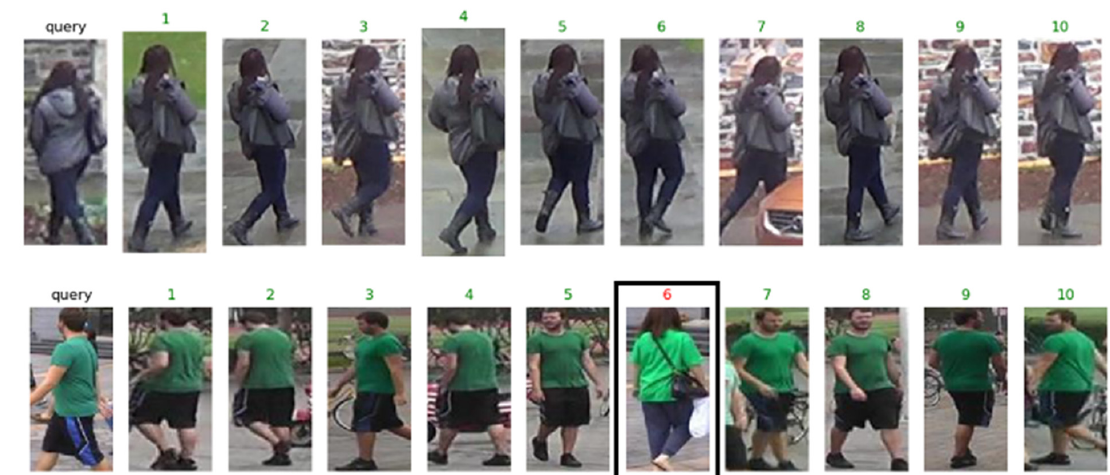
Figure 7. Visualization of person re-identification query results.